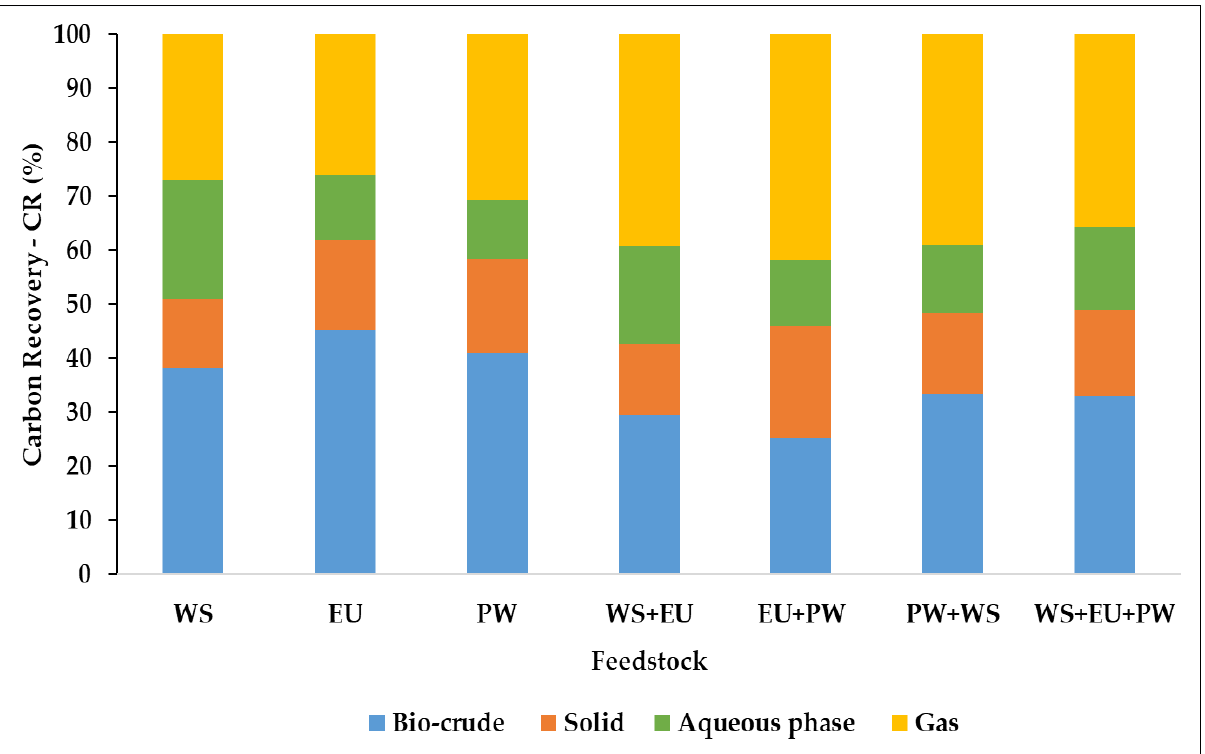
Figure 6. Carbon recovery in HTL products.